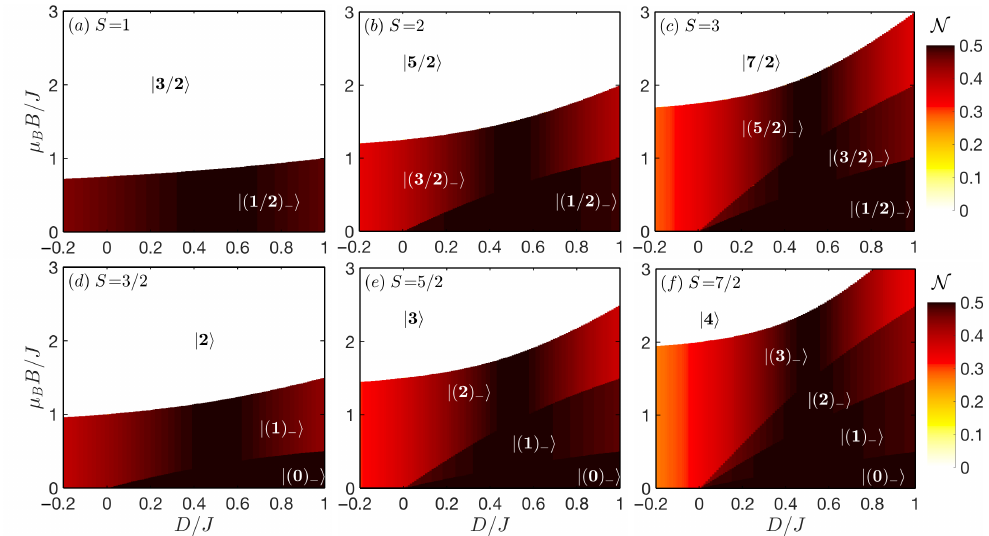
Figure 1. Density plots of a quantum negativity in the D / J − µ B B / J plane for the spin-(1/2, S ) Heisenberg dimers with the antiferromagnetic exchange coupling J > 0 for an integer (upper panels: ( a ) S = 1, ( b ) S = 2, ( c ) S = 3) and half-odd-integer (lower panels: ( d ) S = 3/2, ( e ) S = 5/2, ( f ) S = 7/2) spin magnitude and isotropic interaction ( ∆ =